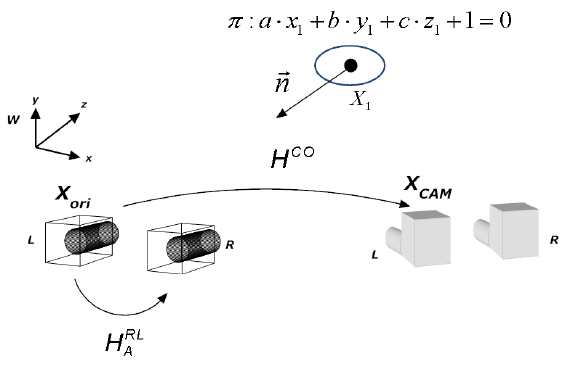
Figure 5. Stereo geometry and locally planar